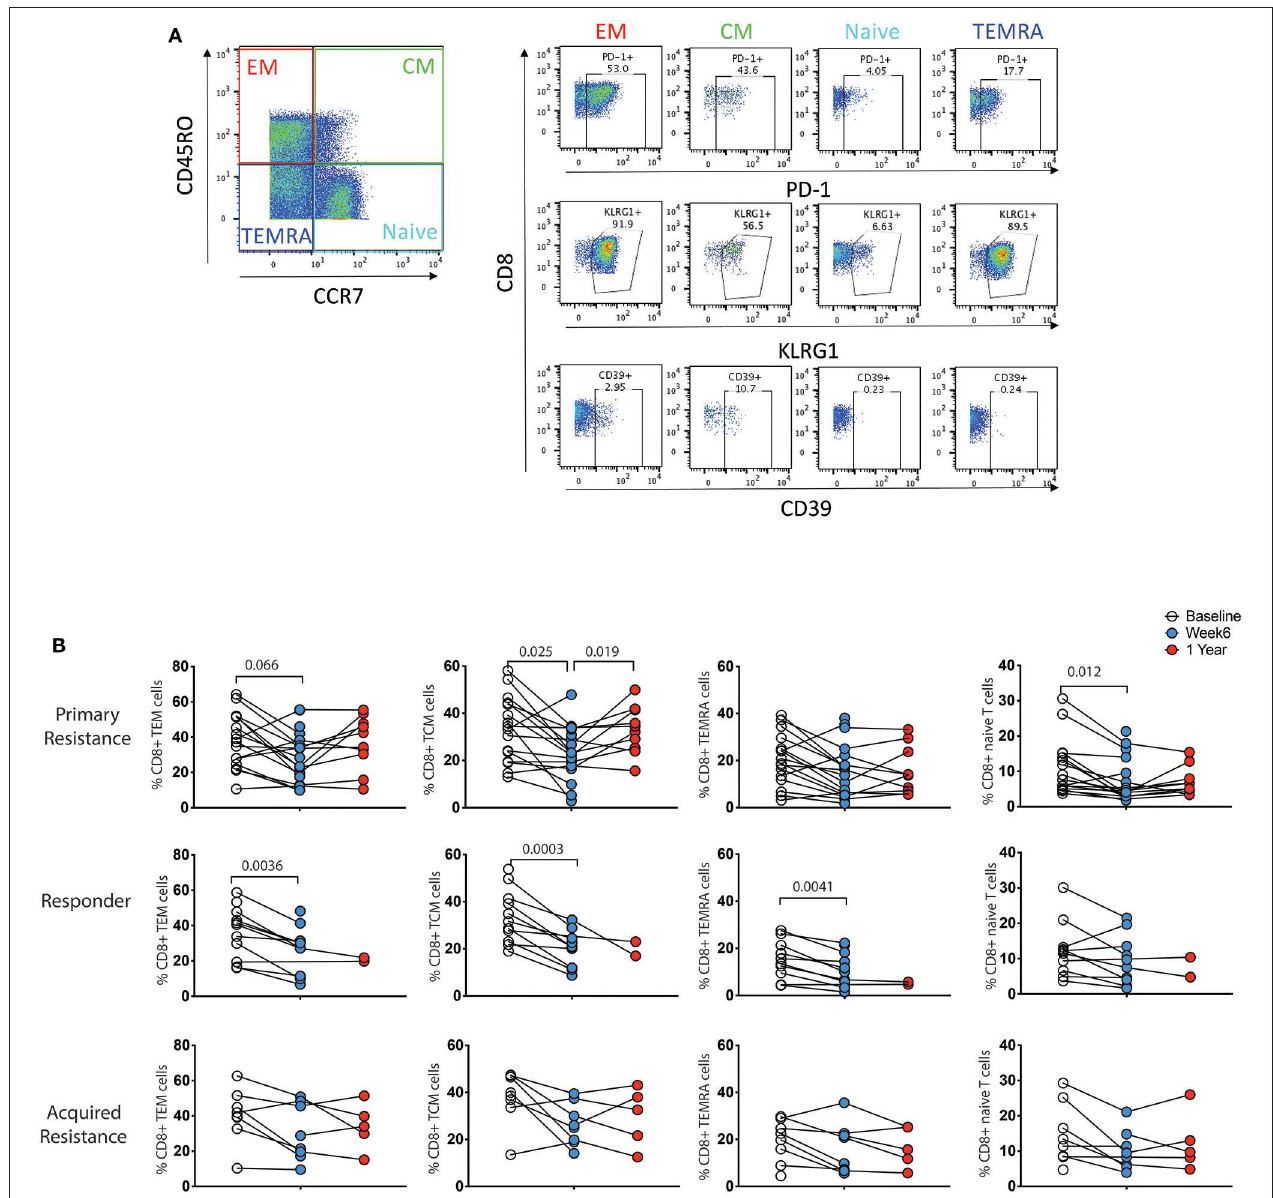
FIGURE 5 | Differential expression pattern of PD-1 within effector/memory compartments of CD8T cells. (A) Gating strategy to distinguish effector memory (TEM), central memory (TCM), effector memory CD45RA (TEMRA), and naïve compartments. (B) Longitudinal analysis of PD-1 expression. Baseline, open circles; week 6, blue filled circles; 1 year, red filled circles. Differences in frequencies of immune cell populations between the 3 timepoints were assessed using a repeated measures mixed effects analysis followed by Tukey’s multiple comparisons test and p -values are